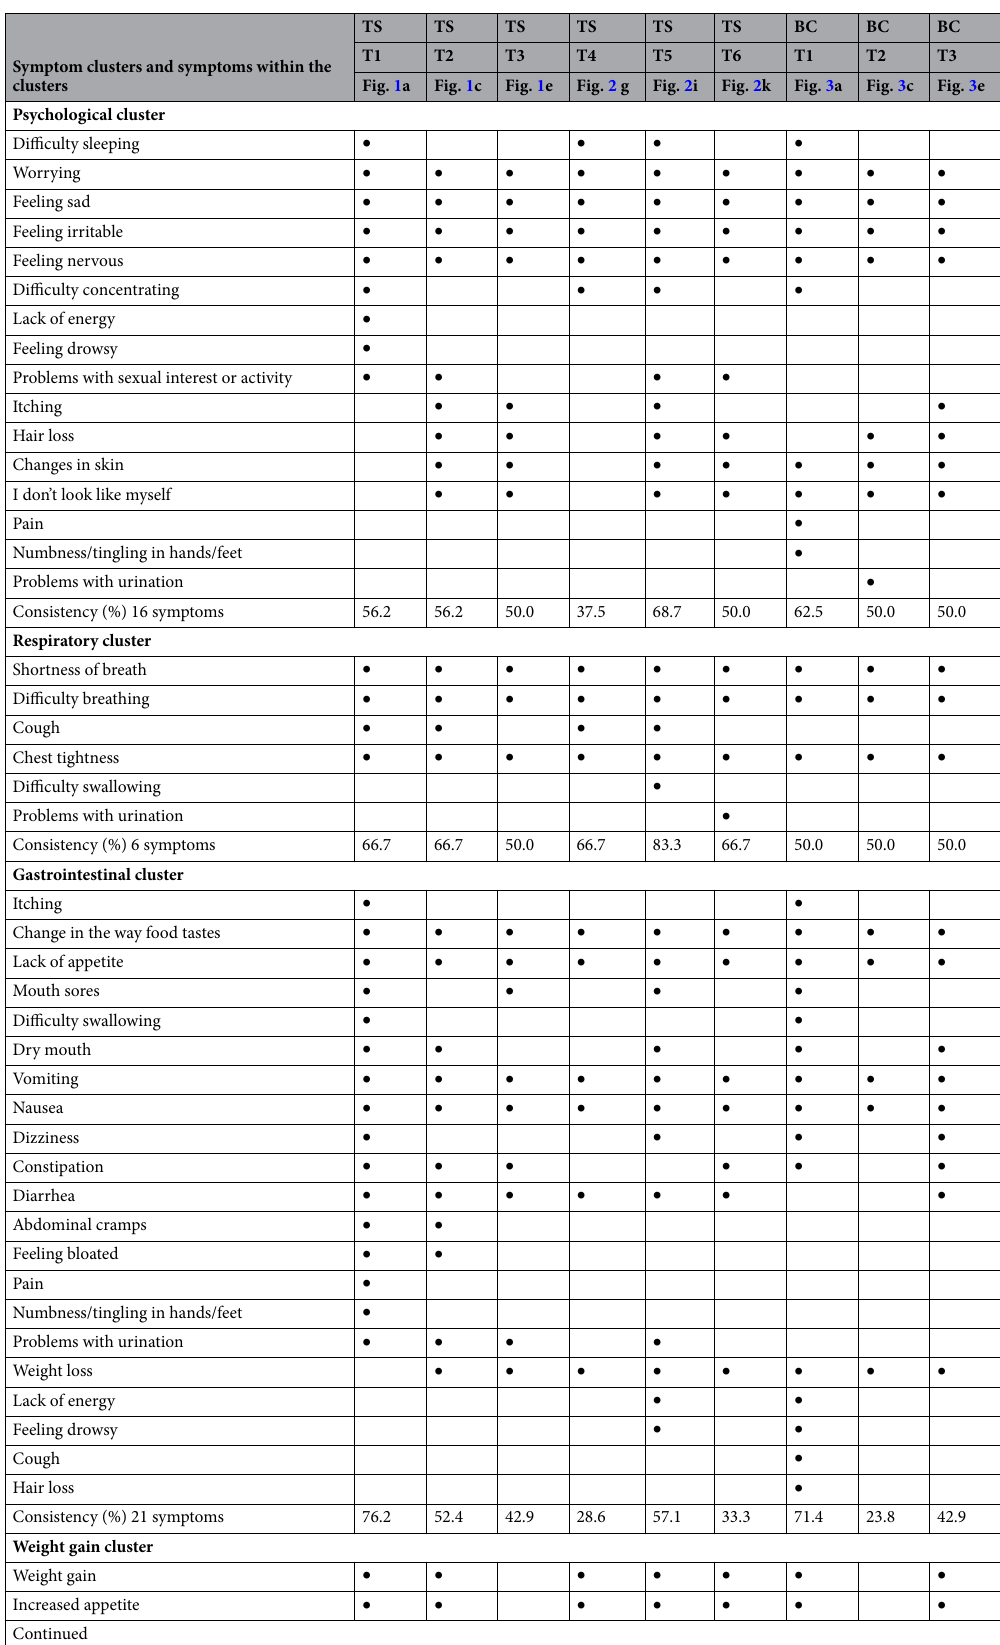
Fig. 1a Fig. 1c Fig. 1e Fig. 2 g Fig. 2i Fig. 2k Fig. 3a Fig. 3c Fig.